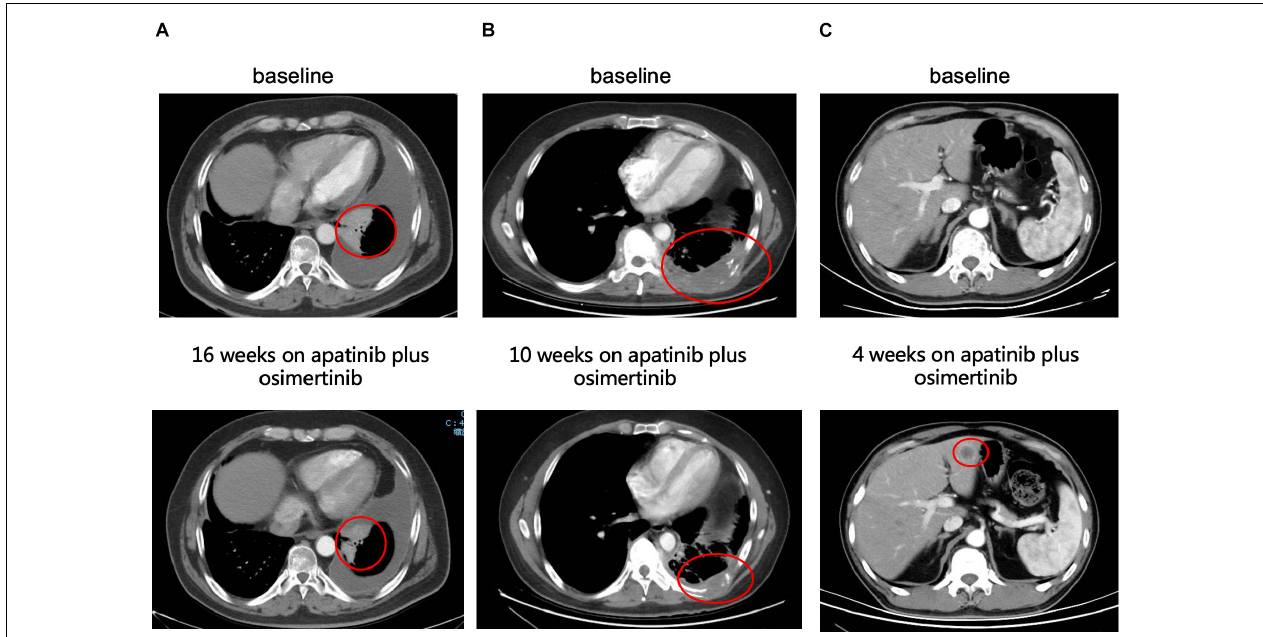
FIGURE 4 | Examples of tumor response to the combination of apatinib and osimertinib in EGFR-positive cases with osimertinib resistance. (A) Partial response of a left lung mass to combination therapy in a patient with TP53 mutation detected post-osimertinib/pre-combined treatment biopsy. This patient remained on treatment at the time of last follow-up. (B) Partial response of a left chest wall mass to combination therapy in a patient with TP53 mutation and ERBB2-amplification detected post-osimertinib/pre-combined treatment biopsy. (C) Progressive disease demonstrated with new hepatic metastases after 1 month of combination treatment in a patient with TP53 and PTEN loss-of-function mutations detected in the post-osimertinib/pre-combined treatment biopsy.